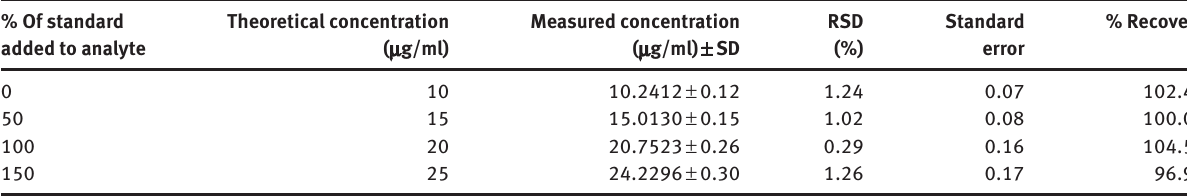
Table 3: Accuracy of the proposed HPLC method (% recovery, n =